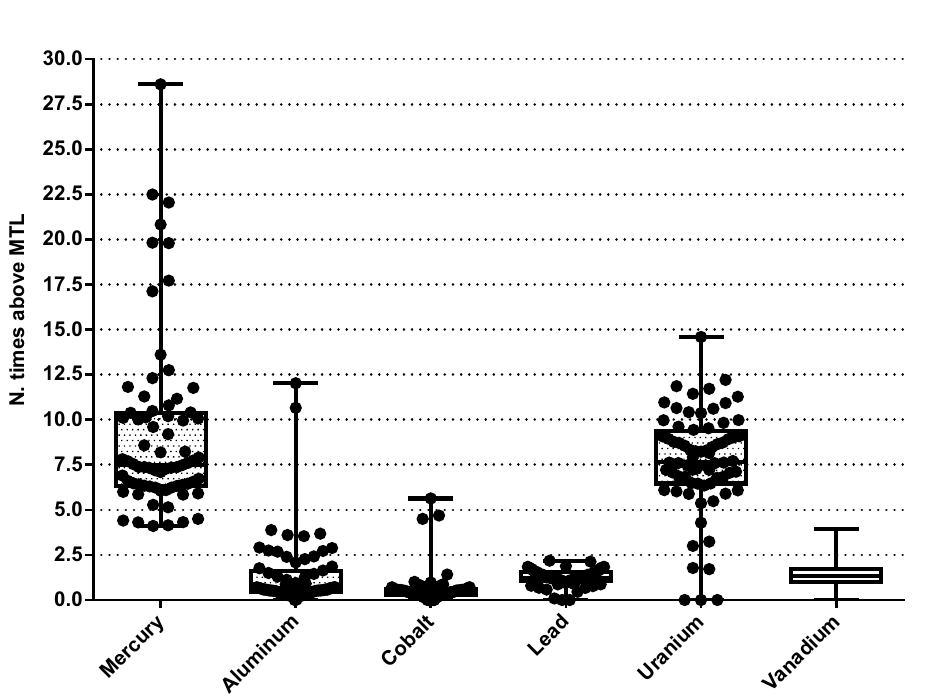
Table 5. Detected toxic metals concentrations (mg/kg DM) in the 28 cat foods evaluated and comparison with the maximum tolerated level of the FDA (2011) and/or legal limit expressed by FEDIAF (2020). MTL maximum tolerated level, LL FEDIAF (2020) legal limit, SD standard deviation. a Reference value of the most sensitive mammal according to the National Research Council (2005). b Reference value according to the United States Food and Drug Administration (2011).